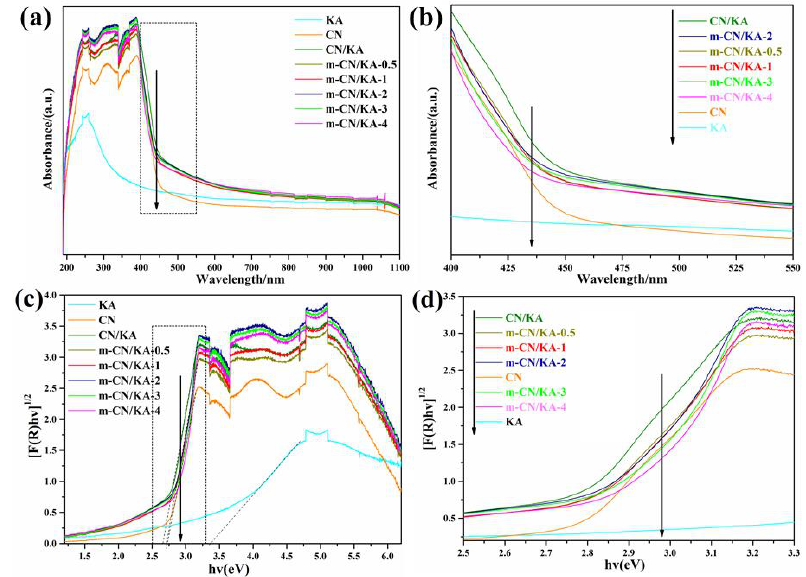
Figure 4. ( a , b ) UV-vis DRS and ( c , d ) band gaps of CN, KA, CN/KA composite, and m-CN/KA composites with different cyanuric acid modifier amounts. composites with different cyanuric acid modifier